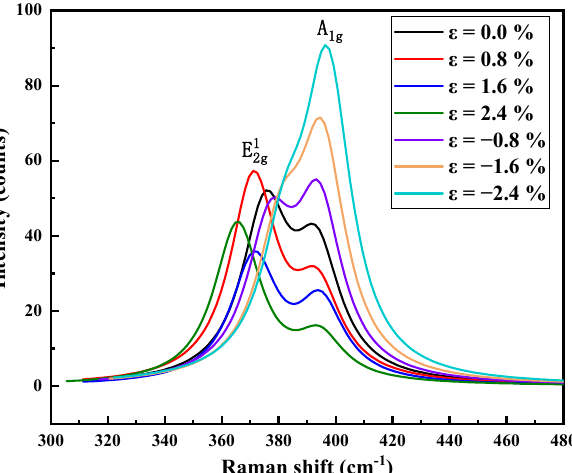
Figure 7. Raman spectrum distribution of a single layer of MoS 2 under tensile strain and compres- sive strain.